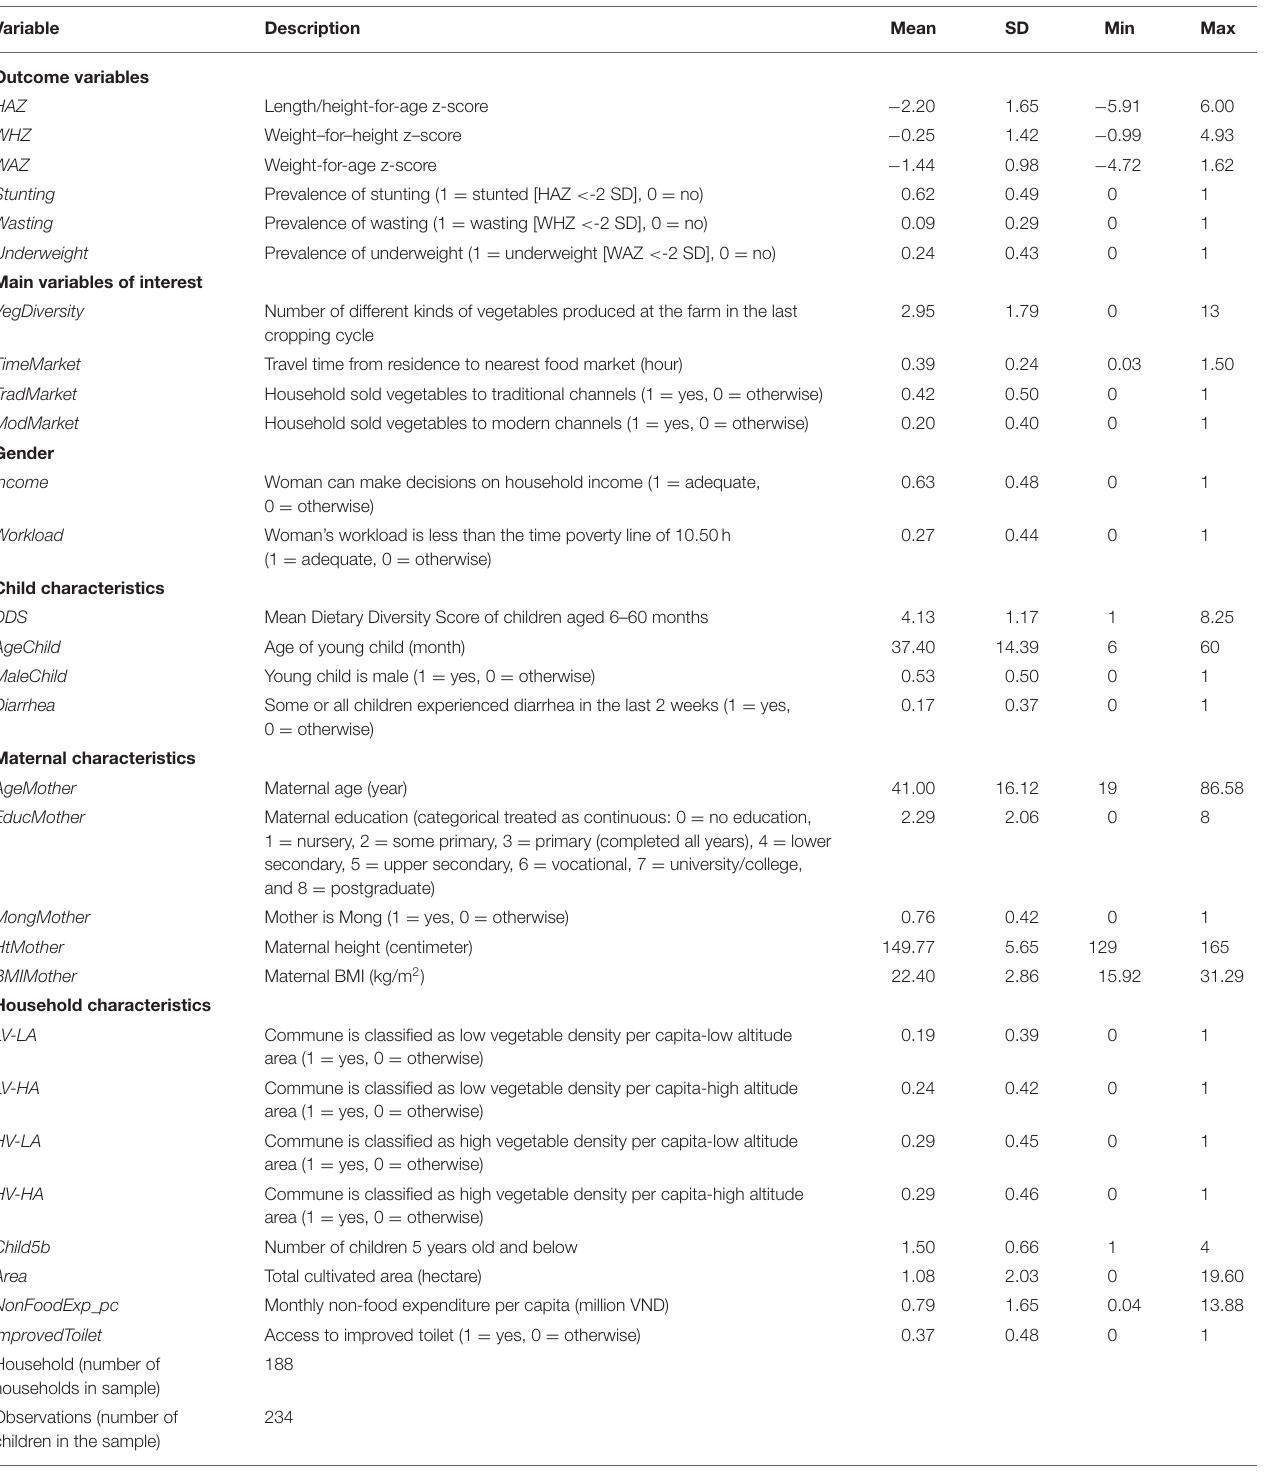
TABLE 1 | Descriptive statistics of key variables of children 6–60 months in Lao Cai province,